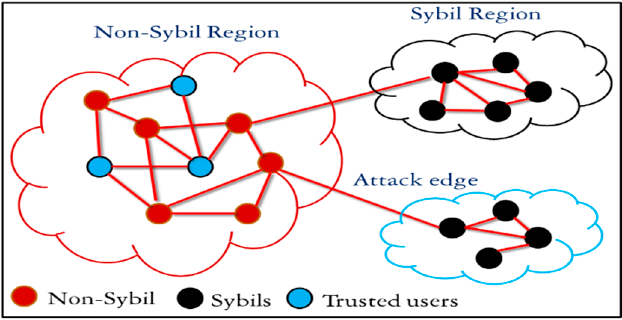
Figure 45. The system model for Sybil attack detection using graphs in SNs (Ref. [154]).